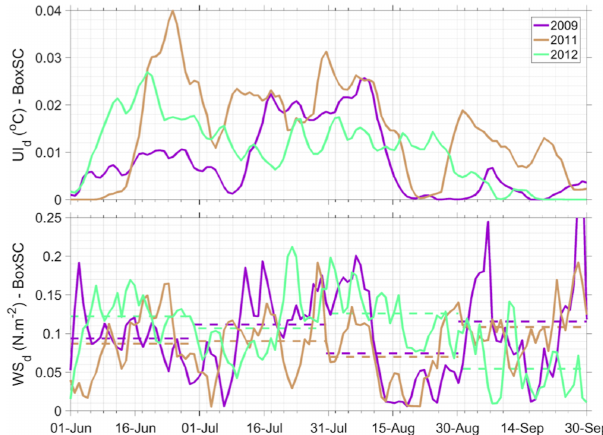
Figure 14. Time series of daily upwelling index (top) and aver- age daily (plain line) and monthly (dashed line) wind stress (bot- tom) over BoxSC between June and September for years 2009 (pur- ple), 2011 (orange), and 2012 (green). For the sake of readability, the y axis is cut off for the last extreme value of September 2009, which corresponds to the passage of storm Ketsana over the SVU region (see the NOAA storm track website at https://coast.noaa.gov/ hurricanes, last access: 25 July 2022).